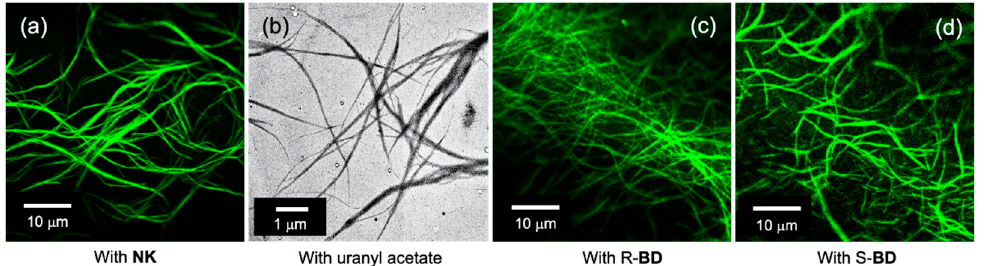
Figure 2. ( a , c , d ) G -CA aggregation in solution at 25 ◦ C observed by confocal laser microscopy and ( b ) a TEM image of a dried sample of the G -CA solution. The confocal images were acquired in the presence of ( a ) NK and the ( c ) R- and ( d ) S-enantiomers of BD. The dried sample of G -CA was prepared by casting and drying on a copper mesh plate. Concentrations: ( a ) G -CA, 0.5 mM; dye, 0.025 mM, ( b ) G -CA, 0.75 mM; dye, 0.05 mM. Solvents: ( a ) toluene and ( c , d ) 95:5 (v/v) methylcy ‐ clohexane:THF.